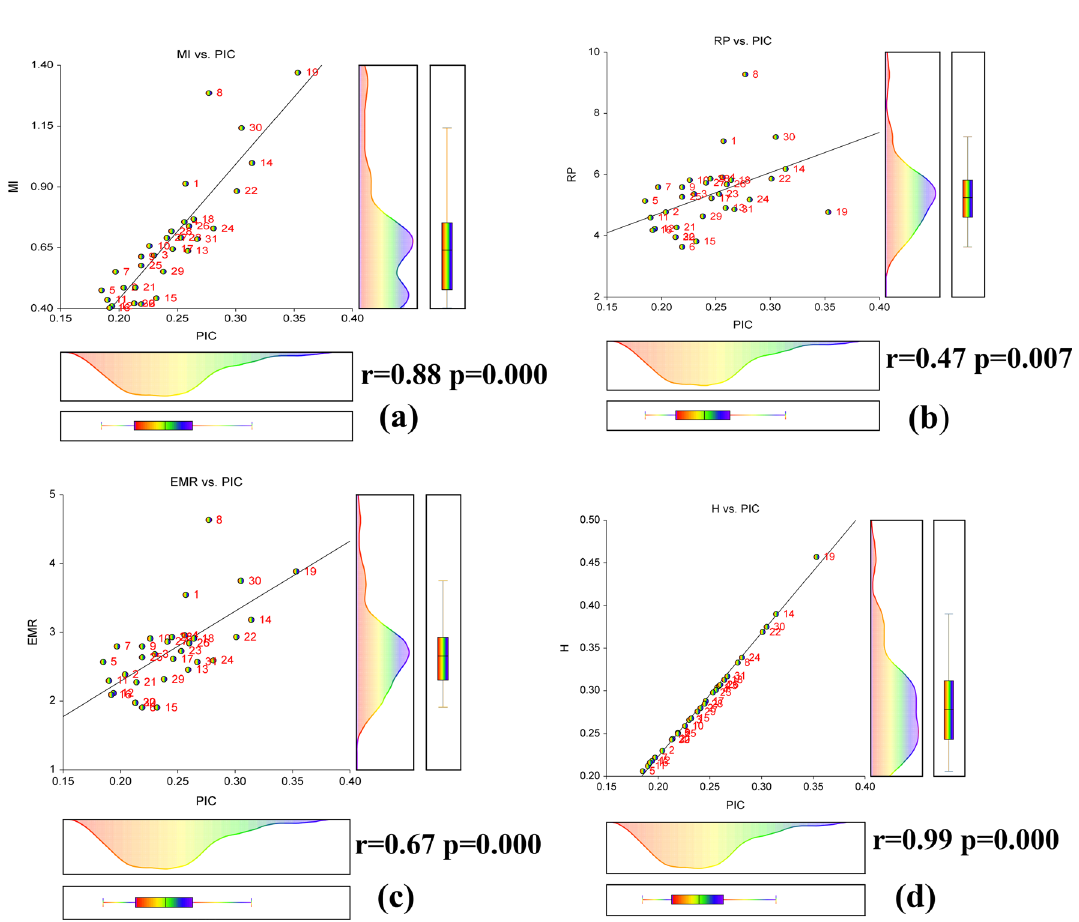
Figure 3. Density plot and box plot showing the relationship and density of primers efficacy. (a) MI vs PIC, (b) Rp vs PIC, (c) PIC vs EMR, and (d) H vs PIC generated by ISSR